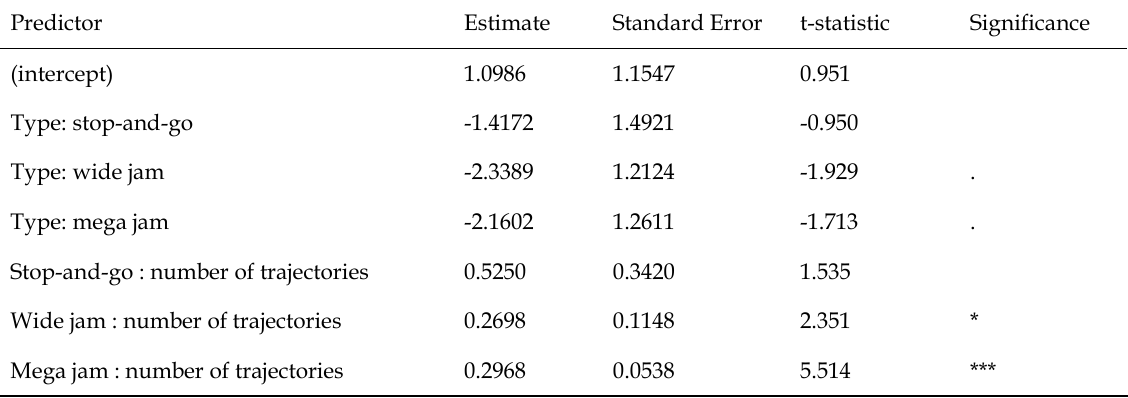
Estimation results of the model with